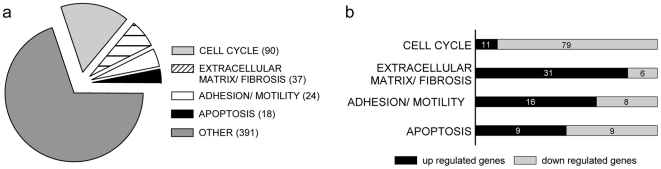
Distribution of differentially expressed genes in ALMS fibroblasts.Fibroblast transcriptional profiles were analyzed by whole genome expression experiments using RNA isolated from healthy controls and ALMS fibroblasts. (a) Pie chart shows the percentage of differentially expressed genes (n = 560) in ALMS fibroblasts clustered in main categories: cell cycle (n = 90), ECM components/fibrosis regulation (n = 37), cellular adhesion/motility (n = 24) and apoptosis (n = 18). (b) Bar chart displays the distribution of up- (black) and down- (grey) regulated genes for each identified group with the number of corresponding genes. A detailed description of the whole genome expression analysis is given in Table S2.